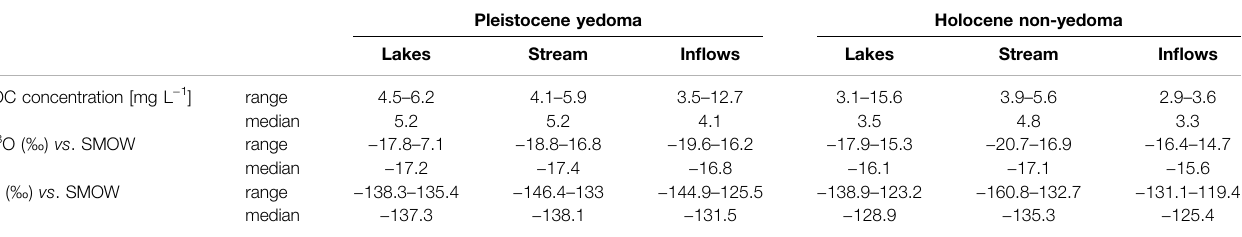
TABLE 1| Overview ofDOC concentrationandisotopiccompositionforlakes, LuckyLake stream, and in fl owsonPleistoceneyedomaand Holocene non-yedoma fromthe years 2013, 2014, 2016, and